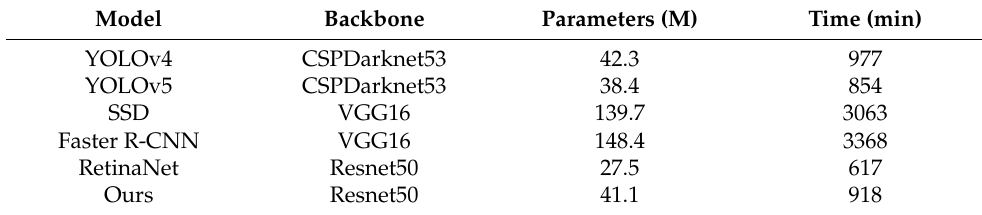
Table 4. Comparison of model complexity.